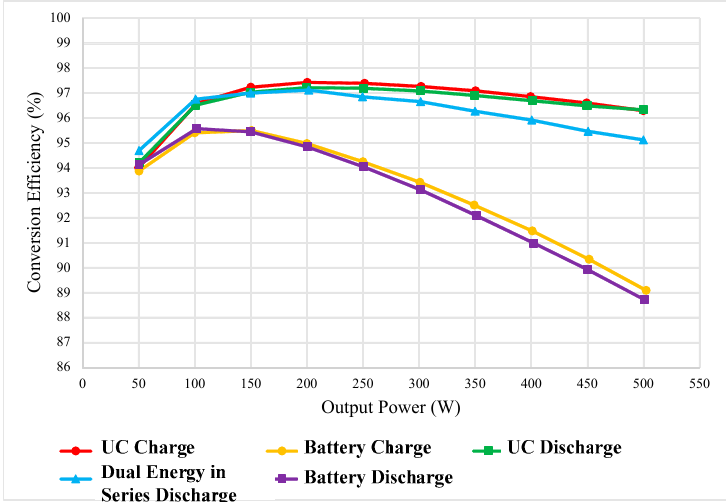
Figure 24. The measured efficiency of the proposed converter for the different operating modes.